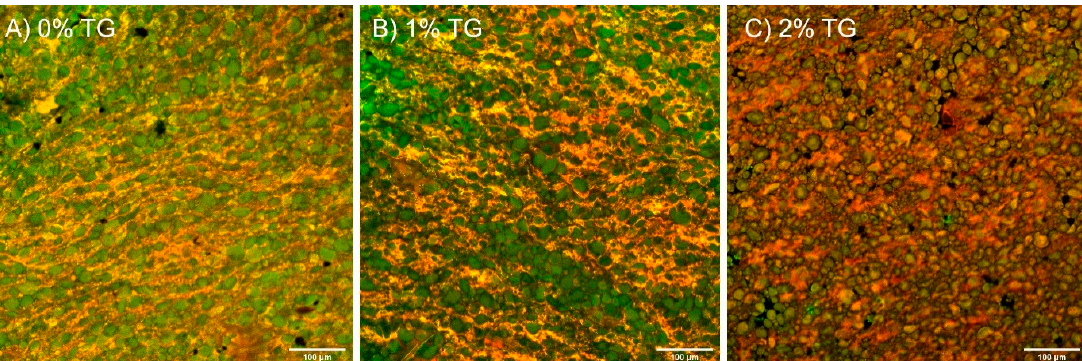
Figure 1. Microstructure of raw noodles with ( A ) 0%, ( B ) 1% and ( C ) 2% transglutaminase at 20 × magnification; scale bar represents 100 µ m; green areas represent starch granules stained by 0.25% w / v fluorescein isothiocyanate (FITC) (488 nm) and yellow / orange areas represent protein stained by 0.025% w / v Rhodamine B (561 nm).